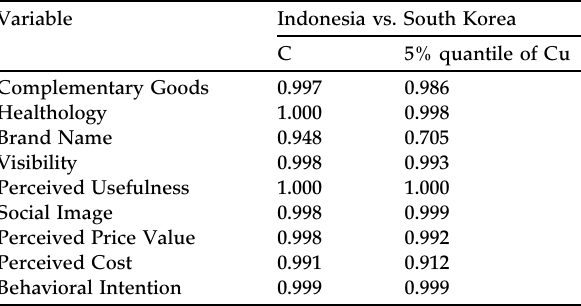
Table 6. Measurement invariance (MICOM) assessment. Variable Complementary Goods